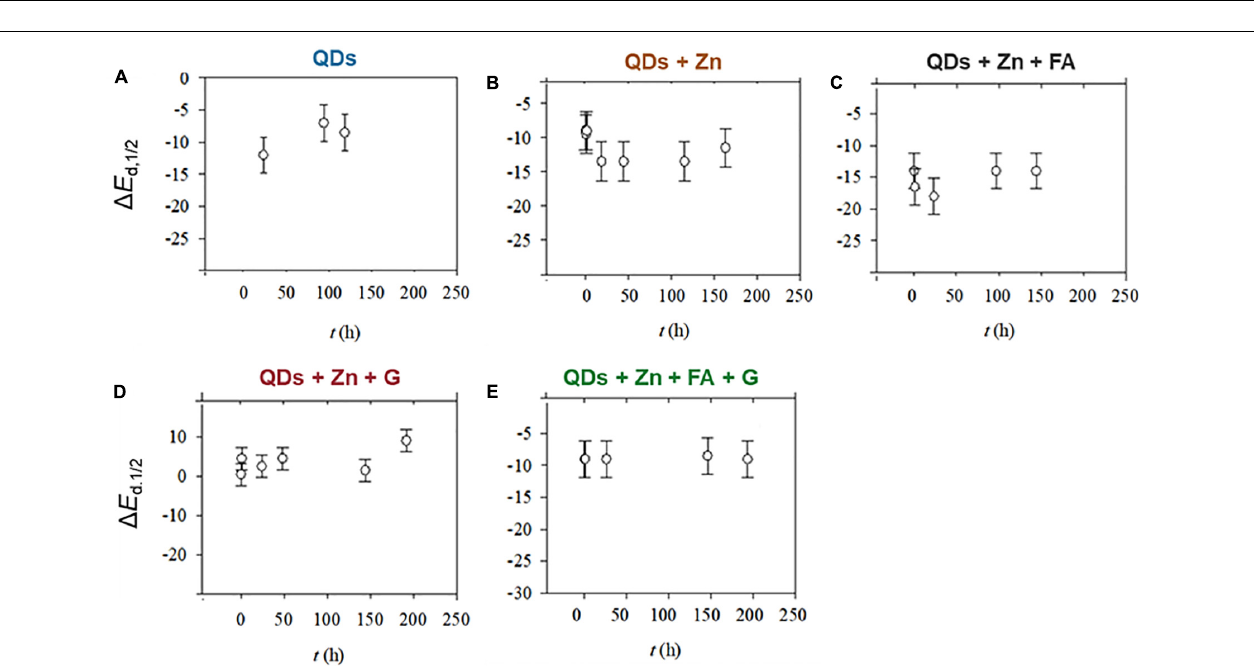
FIGURE 5 | Shift in the half-wave deposition potential, (cid:49) E d , 1 / 2 , for conditions (A–E) . Conditions (A) SRW, (B) SRW-Zn, (C) SRW-Zn-FA, (D) SRW-Zn-G, and (E) SRW-Zn-FA-G.